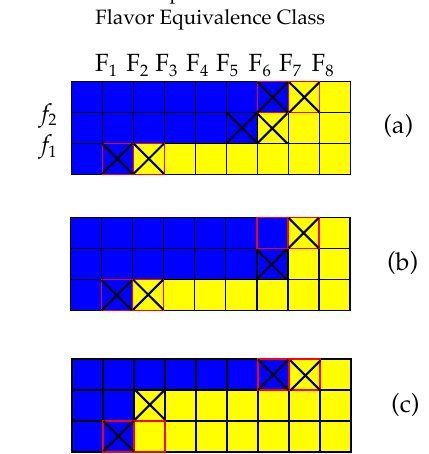
Figure 28. An example of a reduced box graph (r.h.s.) and elements in the same (cid:13)avor equivalence class (box graphs shown on the right) for SU(3) (cid:2) U(9). The F-extremal curves are marked in red, the extremal curves of the box graphs are marked by a cross. This shows that F-extremal curves are not necessarily always extremal for every box graph of the (cid:13)avor equivalence class. The key is that changing the sign assignment of the F-extremal curves results in a di(cid:11)erent SCFT and superconformal (cid:13)avor symmetry. The box graphs in a given (cid:13)avor equivalence class are all distinct gauge theory descriptions that have the same UV (cid:12)xed